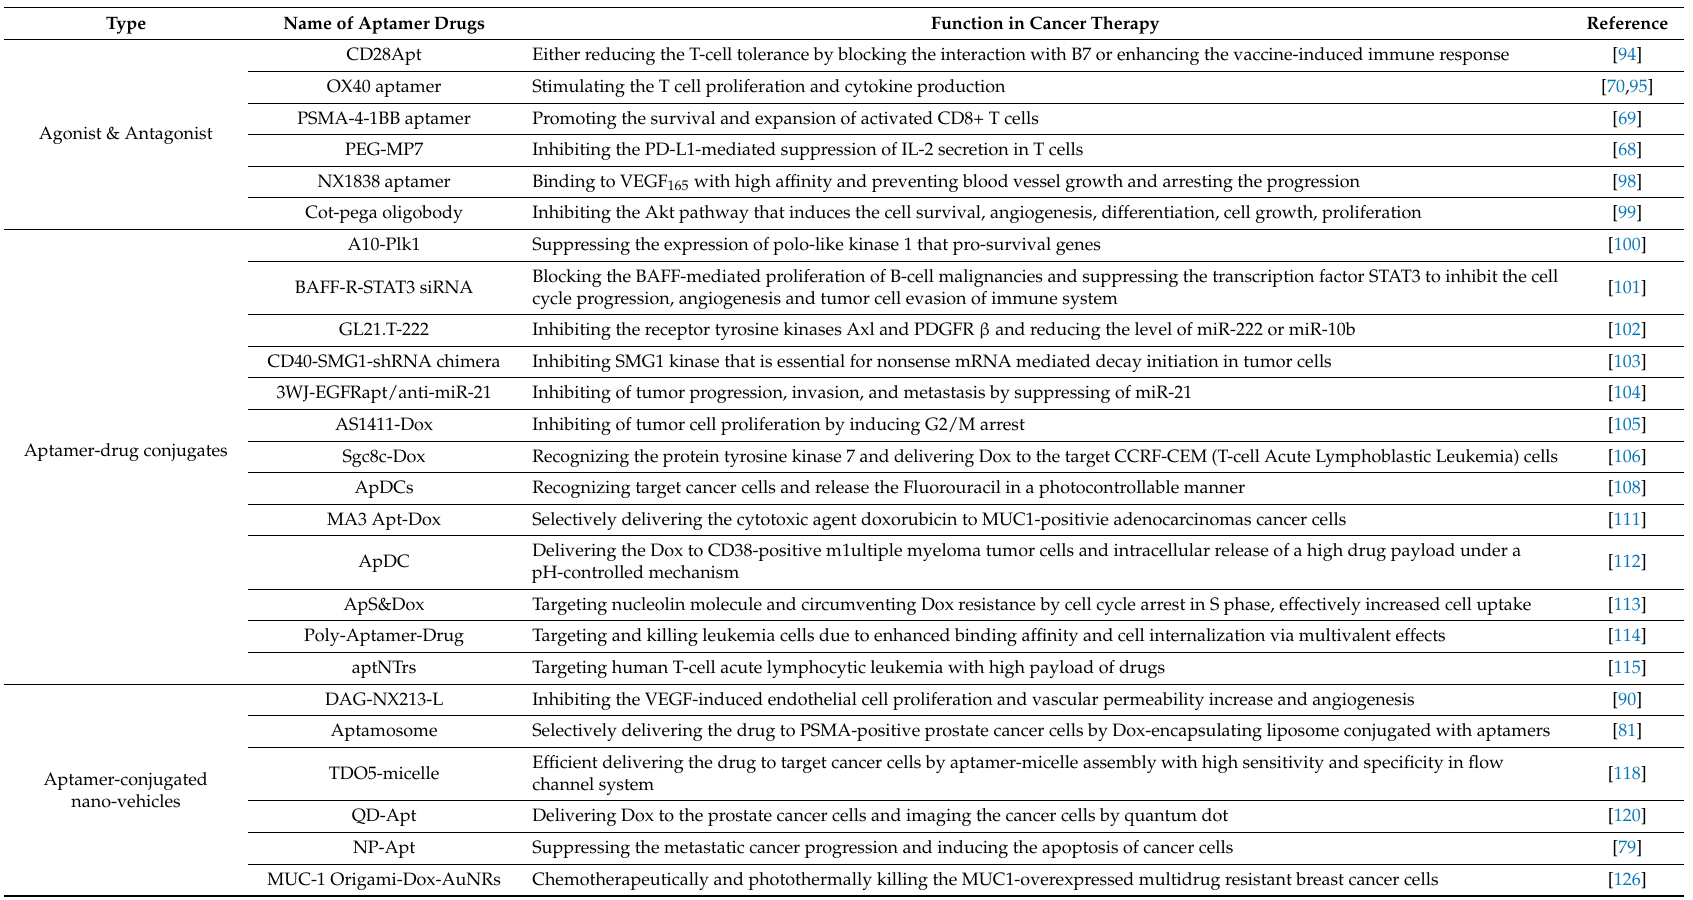
Table 2. Summary of aptamer applications and their functions in cancer